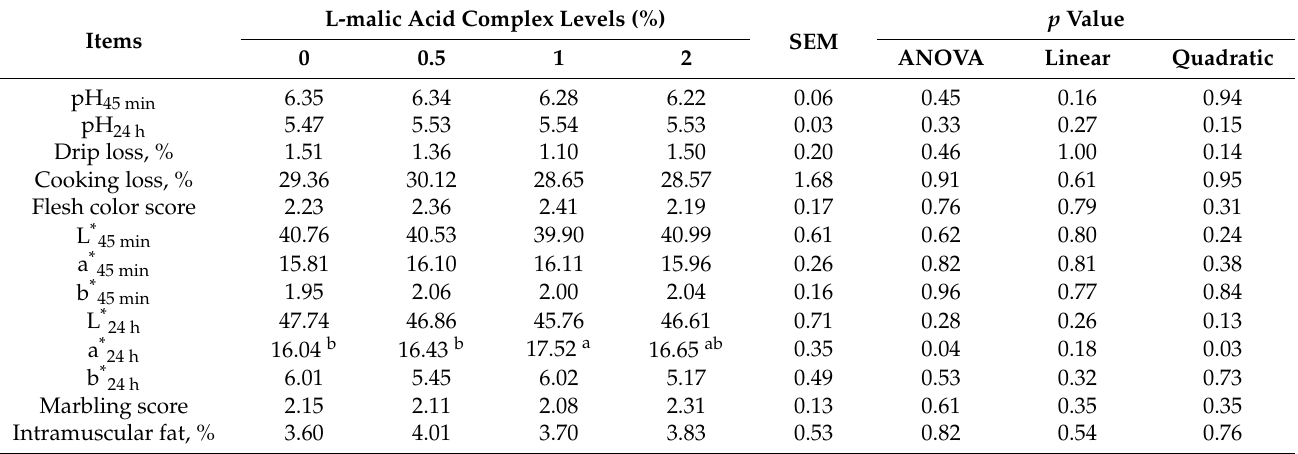
Table 4. Effects of dietary supplementation with L-malic acid on the meat quality of finishing pigs ( n = 8).